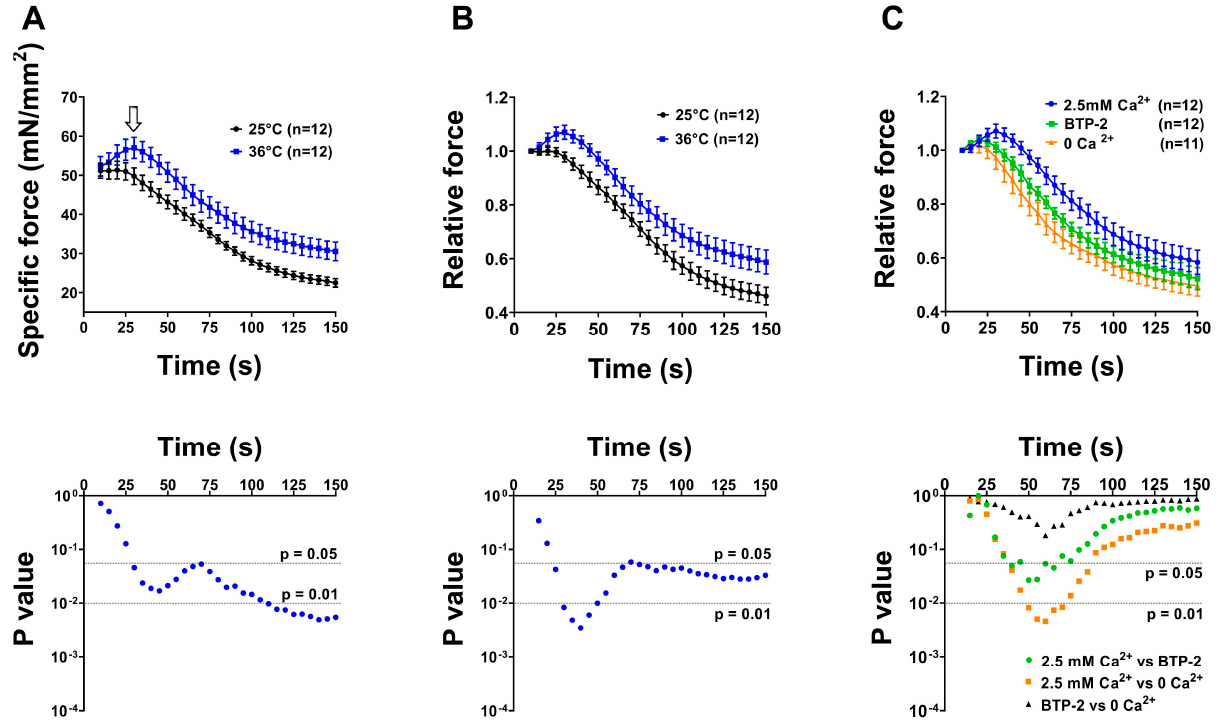
Figure 6.Contractile force of EDL muscles after the ex vivo exercise protocol at 25 vs. 36 °C (pH 7.4) .( A ) Time course of average specific force decay during 30 consecutive frequency stimulus trains (60 Hz, 1 s, every 5 s), normalized to CSA, in EDL muscles previously ex vivo exercised at 25°C or at 36°C. Arrow points to the bump-phase, previously characterized in two papers by Michelucci and colleagues, as the phase of activation of SOCE [81,82]. ( B ) Data represented as relative force (normalized to the first stimulus train). ( C ) Time course of average relative force decay (in presence or absence of 2.5 mM extracellular Ca 2+ and in a solution supplemented with 10µM BTP-2) in EDL muscles previously subjected to the ex vivo protocol at 36 °C. Data are shown as mean ± SEM. Bottom panels represent semi-log plot showing results of multiple unpaired t test (first two panels) or two-way repeated measures ANOVA followed by Tukey post hoc test (right panel). n = number of EDL muscles analyzed for each condition.